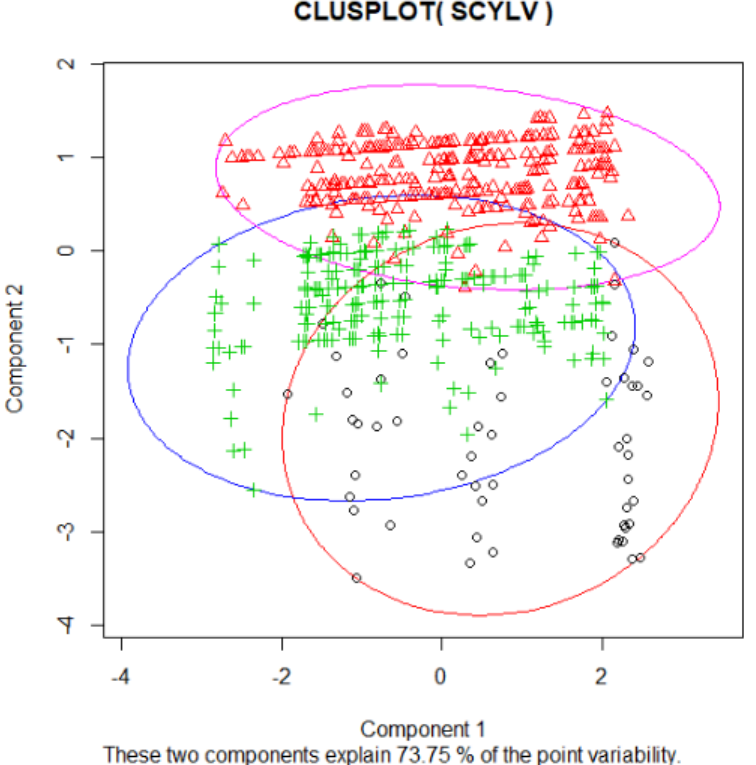
Figure 3. Varieties were divided into three clusters based on percent incidence of SCYLV analyzed by k-means clustering. The red circle represents cluster 1, blue circle cluster 2, and purple circle cluster 3. o, varieties in the cluster 1, +, varieties in the cluster 2 and ∆ ,varieties in the cluster 3. The varieties planted in the primary and secondary increase trials in 2015 had the lowest SCYLV incidence followed by the varieties planted in 2018 but the SCYLV incidence in 2015 and 2018 was not significantly ( p < 0.05) different. Similarly, no significant difference in disease incidence was detected between 2016 and 2017. The percent SCYLV incidence was the highest in 2019 and was significantly ( p < 0.05) higher than all three years (Figure 4).